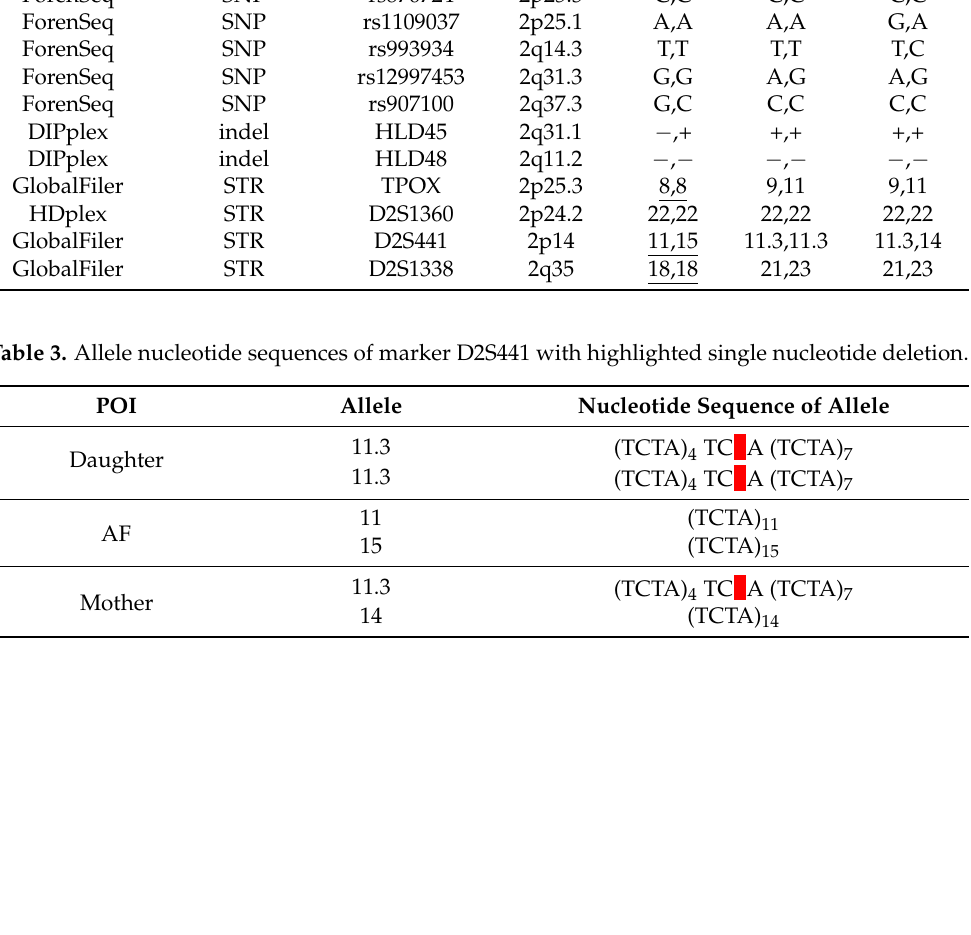
Table 2. Genotypes of the alleged father, mother, and child at different markers located on chromosome 2 and analyzed by commercially available kits. Underlined genotypes show a lack of inheritance of common alleles between the alleged father (AF) and child.